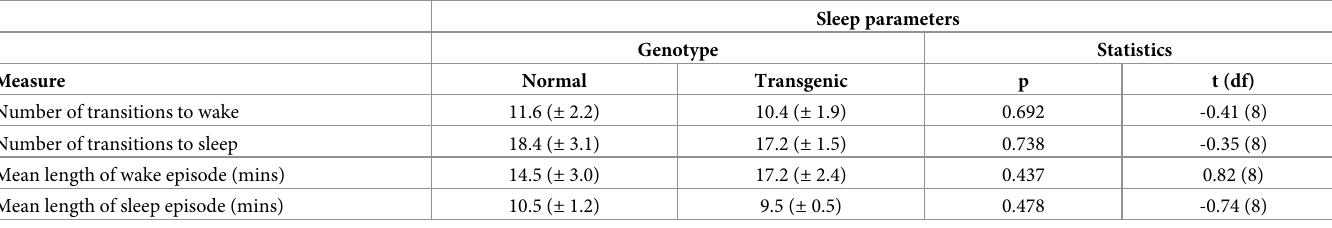
Table 1. General measures of sleep